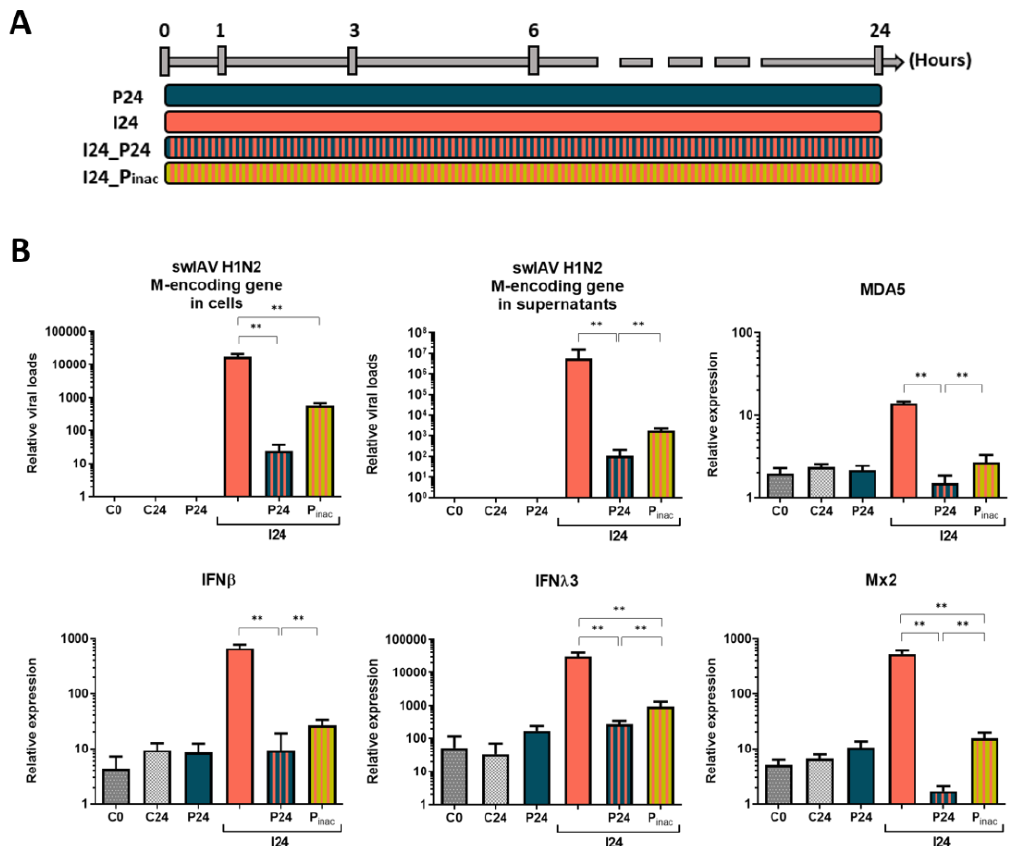
Figure 4. Protocol ( A ) and relative viral loads and relative expression of cellular transcripts ( B ) of the different conditions in newborn pig tracheal cells showing the impact of inactivated PRRSV-1 on swIAV replication and NPTr cells response compared to live PRRSV-1. Cells were infected at an MOI of 3, n = 6 wells per condition for qPCR. C0 and C24 stand for the non-infected conditions over 0 h and 24 h respectively, P24 stands for PRRSV-1 stimulation over 24 h, I24 for swIAV H1N2 infection over 24 h, I24_P24 and I24_Pinac for the coincubation of both viruses over 24 h using live and inactivated PRRSV-1, respectively. Mean values and standard deviations are represented. Comparisons were carried out using a one-way ANOVA test and Tukey’s post-test. Differences were considered significant when p < 0.05 (*) or p < 0.01 (**).